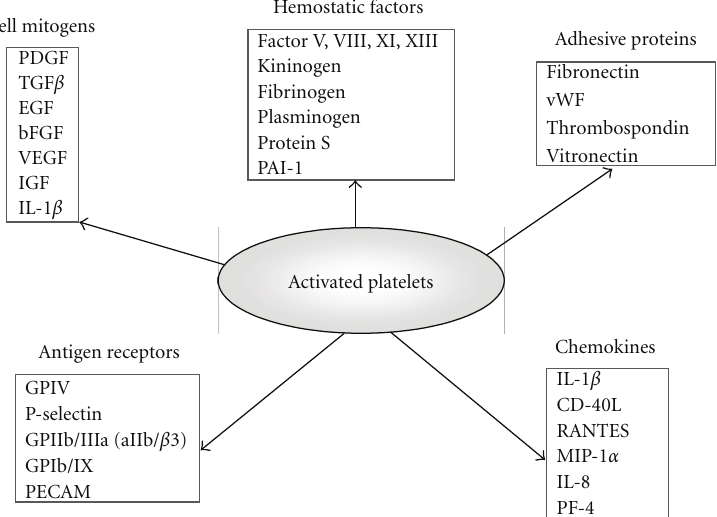
Figure 2: Platelet components involved in the coagulation cascade and the atherosclerotic process. PDGF, platelet-derived growth factor; TGF β , transforming growth factor β ; EGF, endothelial growth factor; bFGF, fibroblast growth factor; VEGF, vascular endothelial growth factor; IGF, insulin-like growth factor; IL-1 β , interleukin-1 β ; PAI-1, plasminogen activator inhibitor 1; vWF, von Willebrand factor; GP, glycoproteins; PECAM, platelet and endothelial cell adhesion molecule; CD40L, CD40 ligand (CD154); RANTES, regulated on activation, normal T-cell expressed and secreted; MIP-1 α , macrophage inflammation protein 1 α ; IL-8, interleukin-8; PF4, platelet factor